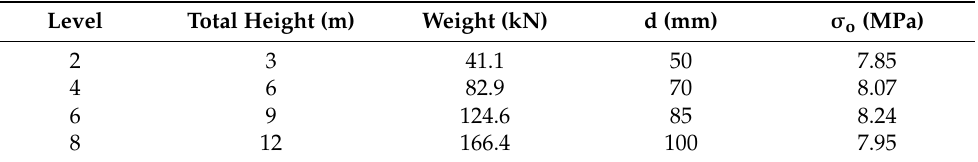
Table 1. Diameter of the balls in the isolator ball joint base support. Level Total Height (m) Weight (kN) d